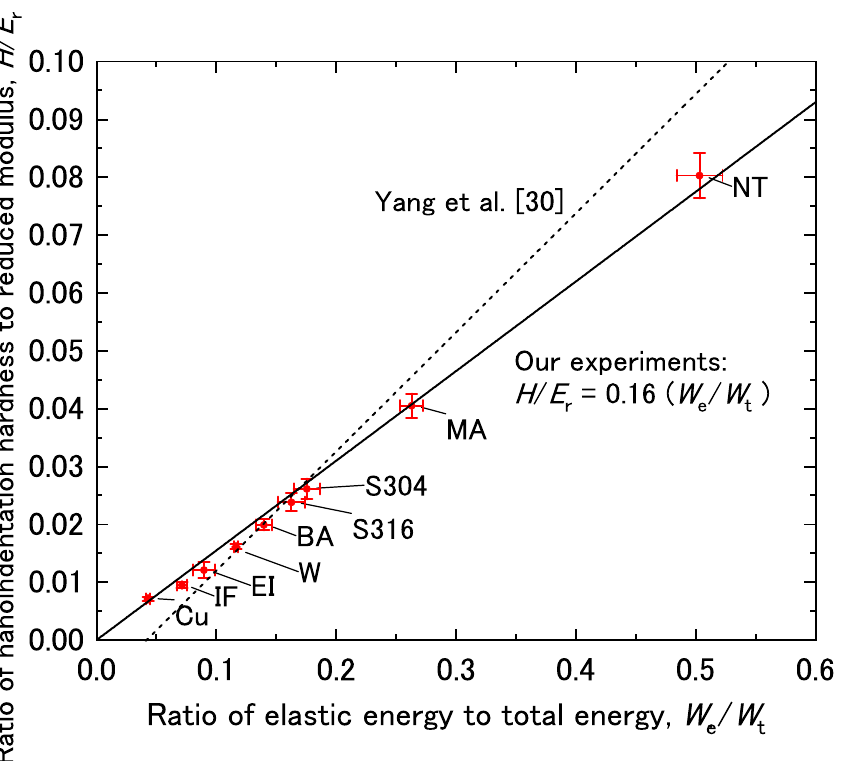
Figure 2. Ratio of nanoindentation hardness to reduced modulus ( H / E r ) as a function of the recovery index ( W e / W t ). The error bars are drawn with the standard deviation.